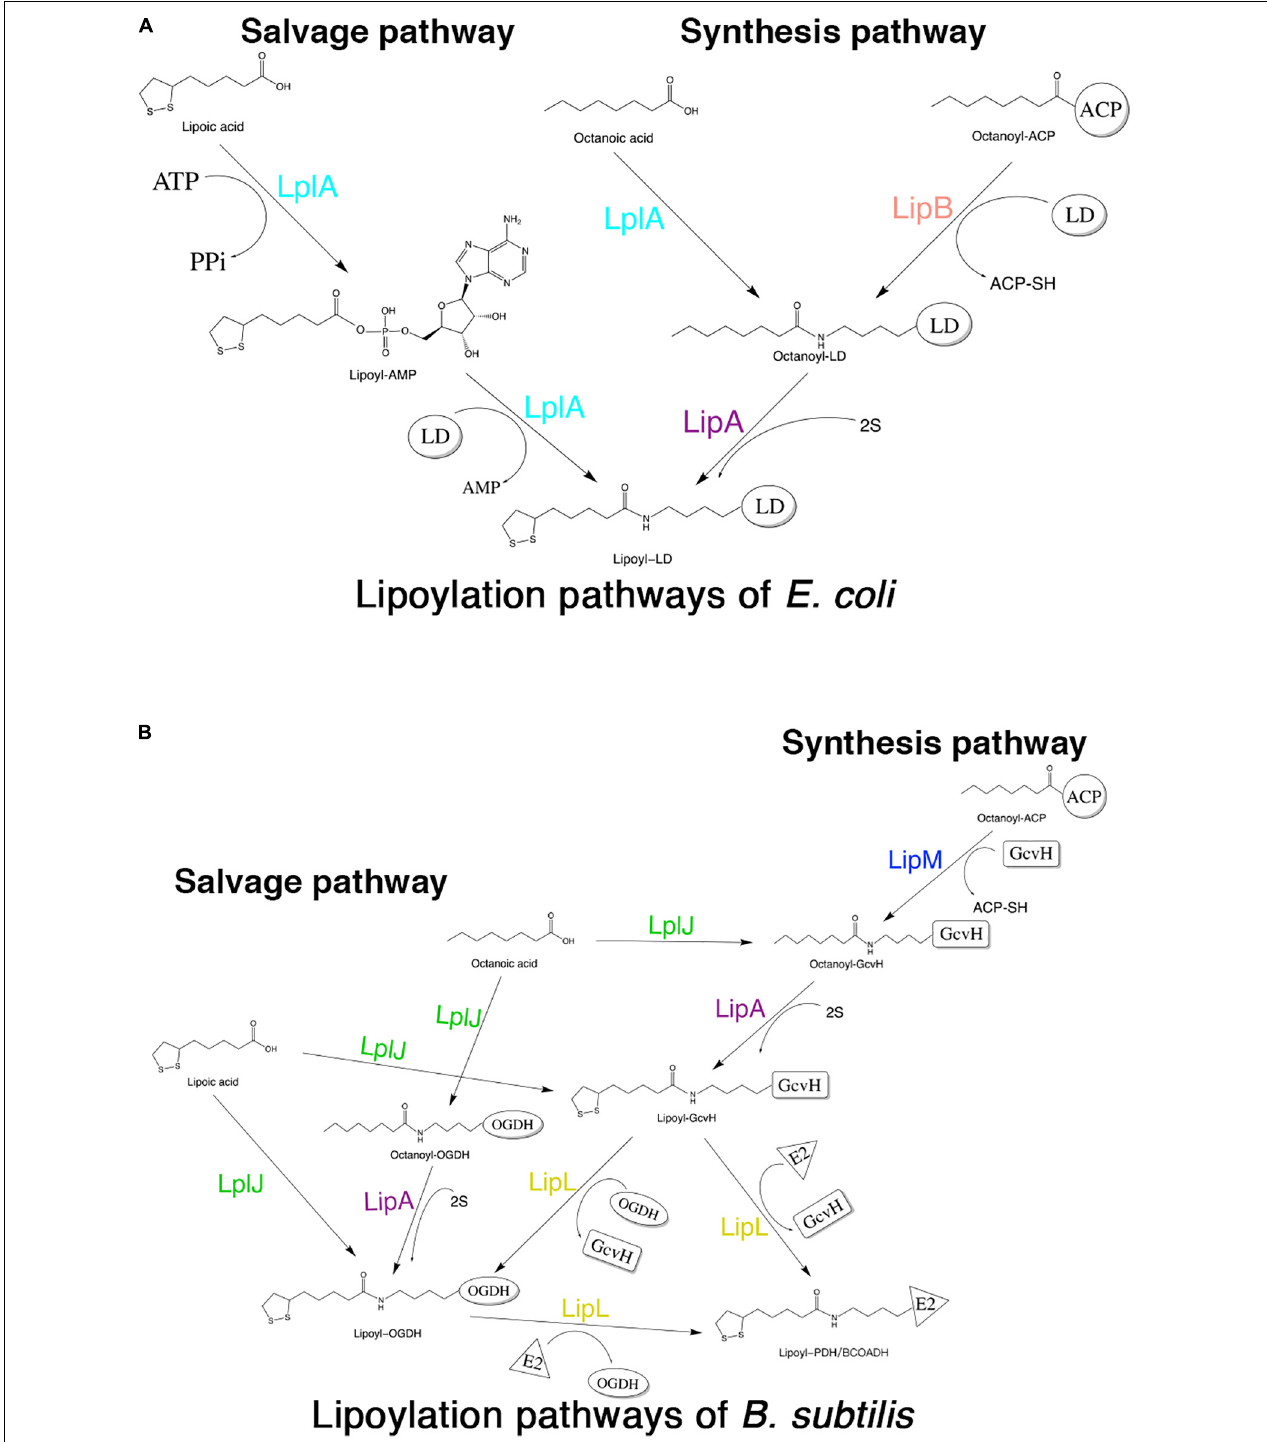
FIGURE 1 | Schematic diagram of lipoic acid metabolism pathways in E. coli and B. subtilis . Both E. coli and B. subtili s have two independent pathways for lipoic acid metabolism. (A) Lipoylation pathways of E. coli . LplA is able to transfer both free lipoic acid as well as free octanoic acid to the apo-proteins in the salvage pathway. LipB and LipA are involved in the lipoic acid synthesis pathway of E. coli . LD: lipoly domain of lipoate-dependent protein. (B) Lipoylation pathways of B. subtili s. In the salvage pathway, LplJ can only modify GcvH and OGDH, and that LipL is necessary to lipoylate the E2 subunits of PDH and BCOADH (represented by E2). In the synthesis pathway, first, LipM specifically transfers octanoate from ACP to GcvH. Then, LipA catalyzes sulfur insertion to form lipoyl-GcvH and LipL transfers the lipoyl group from GcvH to other lipoate-requiring subunits. The lipoyl-OGDH could also serve as a lipoate donor for the lipoylation of PDH and BCOADH.